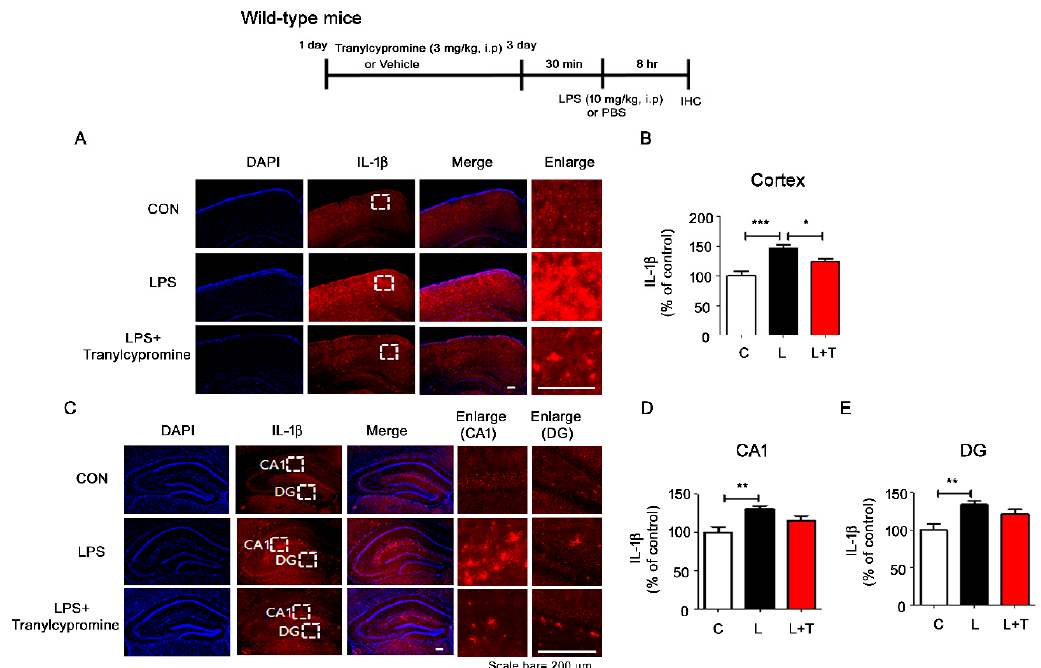
Figure 6. Tranylcypromine downregulates LPS-mediated proinflammatory cytokine IL-1 β levels in the cortex in wild-type mice. ( A – E ) After daily injection with tranylcypromine (3 mg / kg, i.p.) or PBS for 3 days, wild-type mice were injected with LPS (10 mg / kg, i.p.) or PBS. Perfused and fixed mice were then subjected to immunohistochemistry with an anti-IL-1 β antibody (cortex, hippocampus CA1 and DG: con, n = 4 mice; LPS, n = 5 mice; tranylcypromine, n = 5 mice). * p < 0.05, ** p < 0.01, *** p < 0.001. CON and C, control; L, LPS; L + T, LPS + Tranylcypromine.